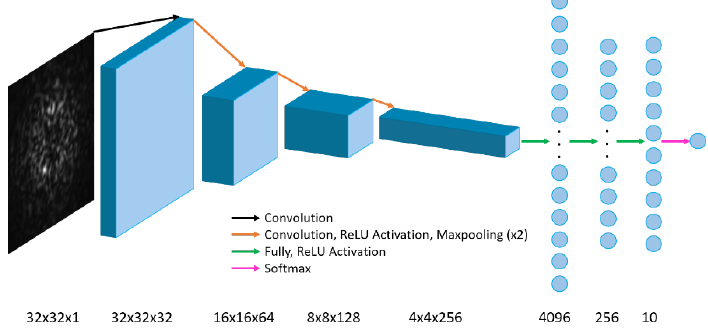
Figure 2. Schematic representation of the deep neural network (DNN) architecture used for the classificationofthespecklepatternsrecordedatthefiberoutputfordi ff erentphaseinputs. classification of the speckle patterns recorded at the fiber output for different phase inputs. The VGG- type network is trained to receive the image of a speckle pattern intensity and provide a label for the input digit.